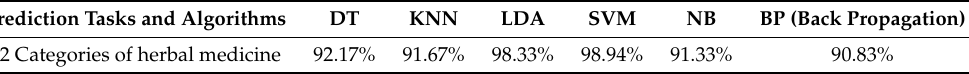
Table 2. Classification performances of different